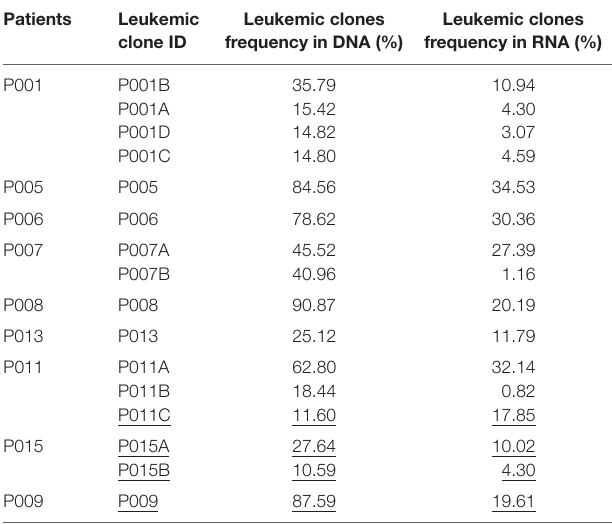
TaBle 2 | The frequency of leukemic clones in Dna and rna of the same bone marrow samples. Patients